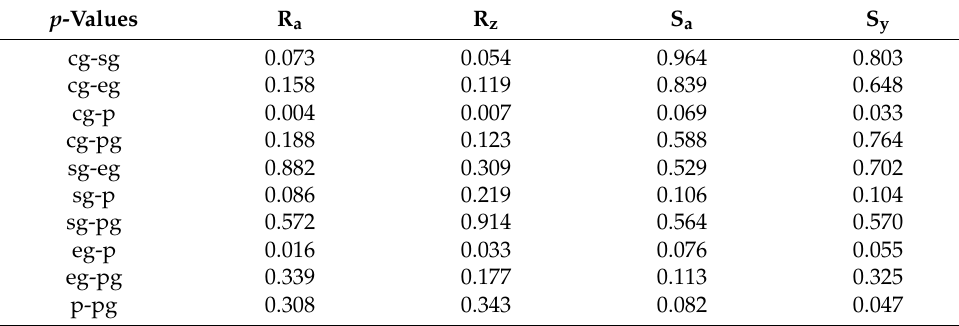
Table 6. p -Values related to conditioning method, after finishing.